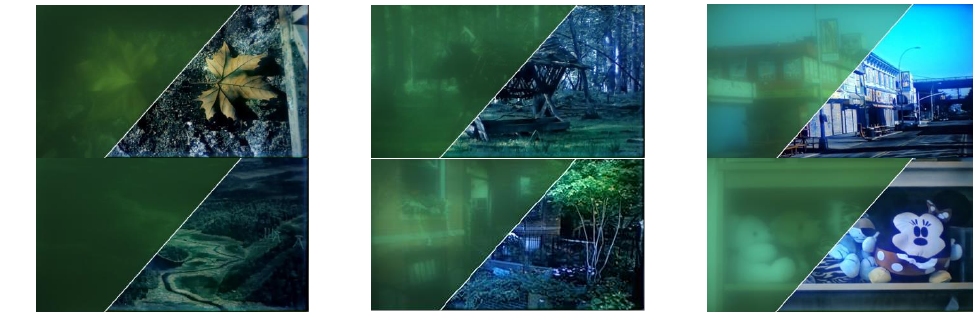
Figure 9. RRG-GAN restoring results based on manual dataset.